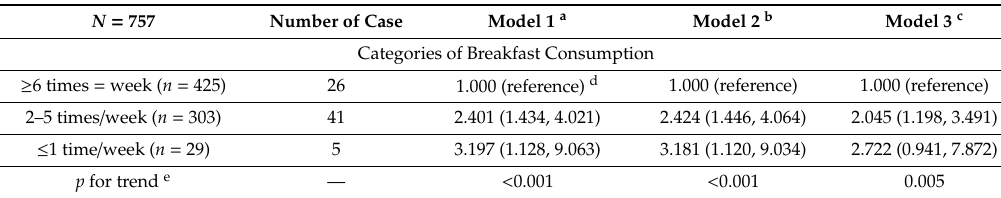
Table 3. Adjusted relationships between breakfast consumption frequency and the risk of depressive symptoms incidence during the 1-year follow-up